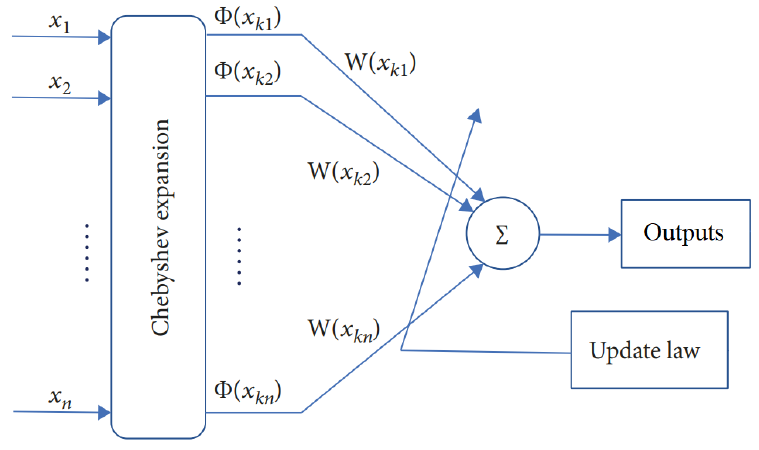
Figure 2. The configuration of the ChNN.